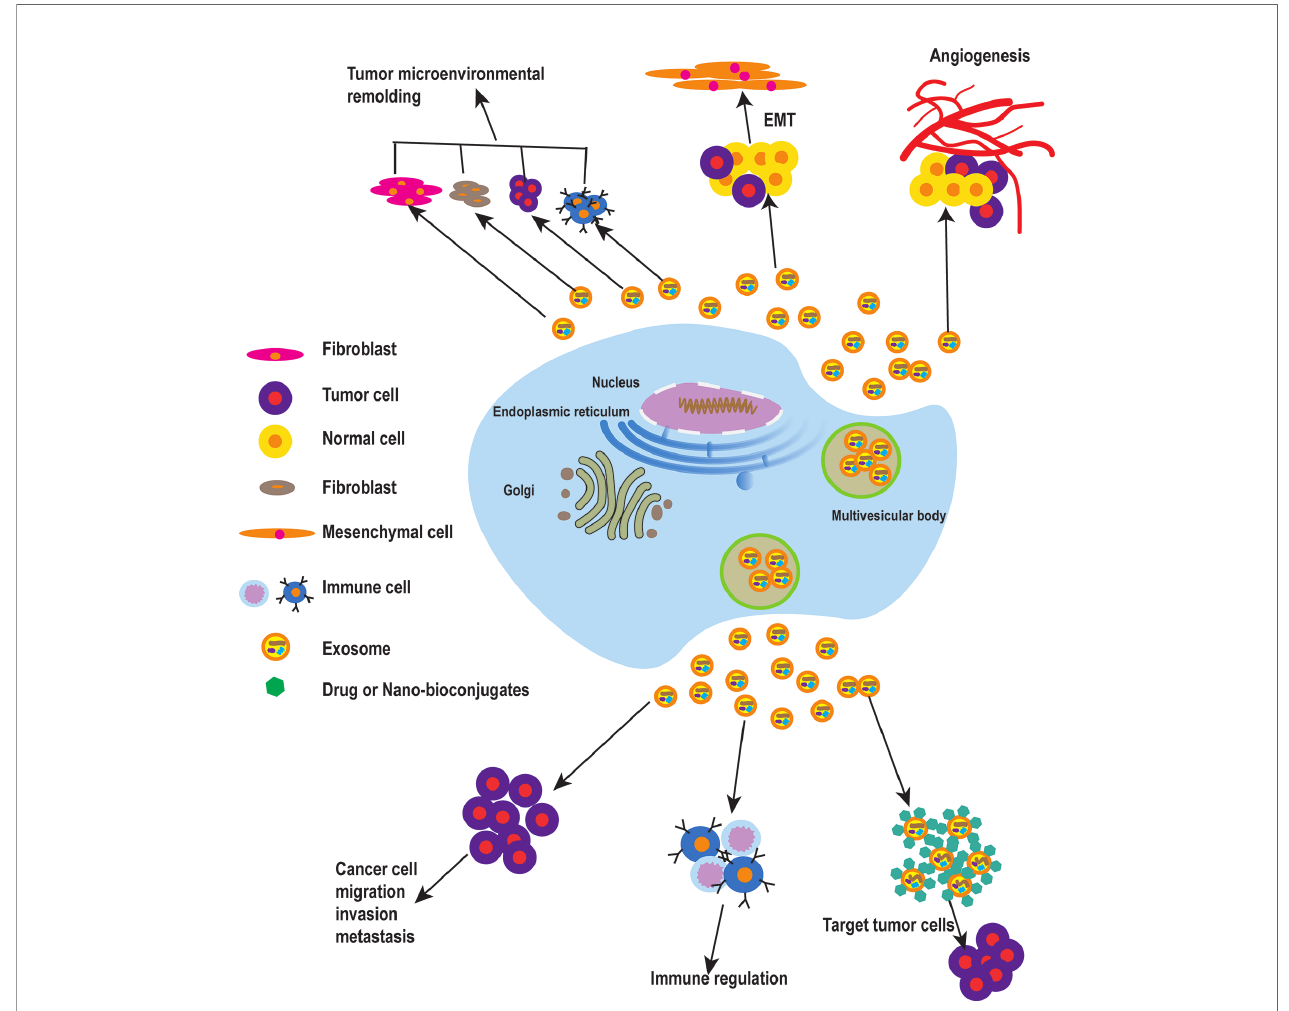
FIGURE 1 | The roles of exosomes in cancer. Tumor cell-derived exosomes play a vital role in the remodeling of the tumor microenvironment, and can promote EMT and increase the motility and invasiveness of tumor cells, leading to tumor migration and metastasis. When tumor cells reach new metastasis sites in vivo , tumor cell-derived exosomes can promote the formation of new blood vessels. To enable tumor metastasis, exosomes also can promote tumor metastasis by involving in immune regulation. Finally, exosomes can be used as a carrier for drug delivery in cancer